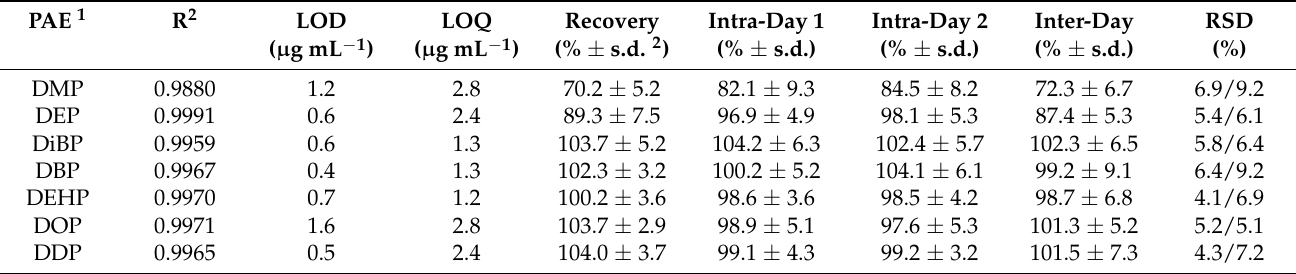
Table 3. Correlation coefficients (R 2 ) in the range 5–500 µ g mL − 1 , limit of detection (LOD), limit of quantification (LOQ), recoveries and intra-day and inter-day precision along with relative standard deviation (RSD) in coffee samples of each PAE investigated by means of UVA-DLLME